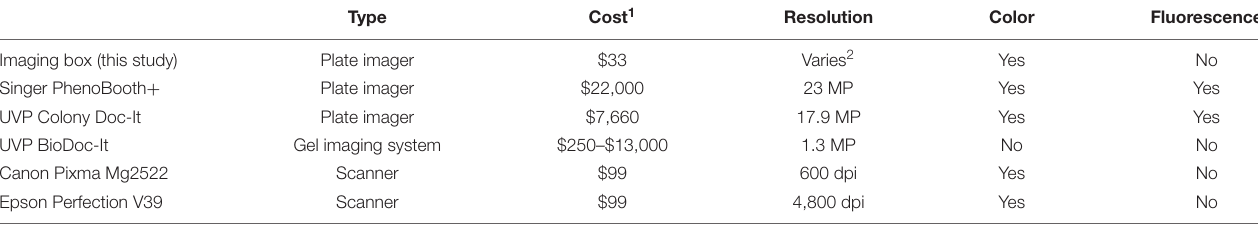
TABLE 1 | Comparison of the imaging box to other devices. Type Cost 1 Resolution Color Fluorescence